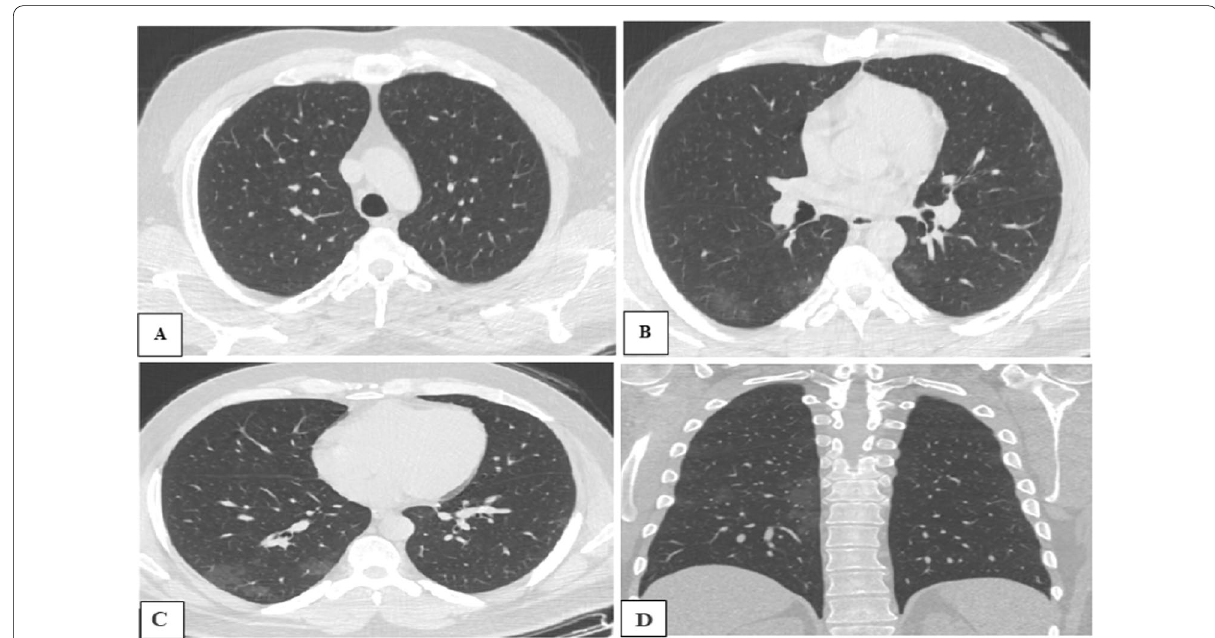
Fig. 1 51-years old male patient, with blood group O, having COVID-19 pneumonia, and referred for CT chest assessment. A – C Axial and D coronal CT chest images shows bilateral sub-pleural variable-sized ground-glass opacities. Calculated CT severity score was 4 and such case was considered mild